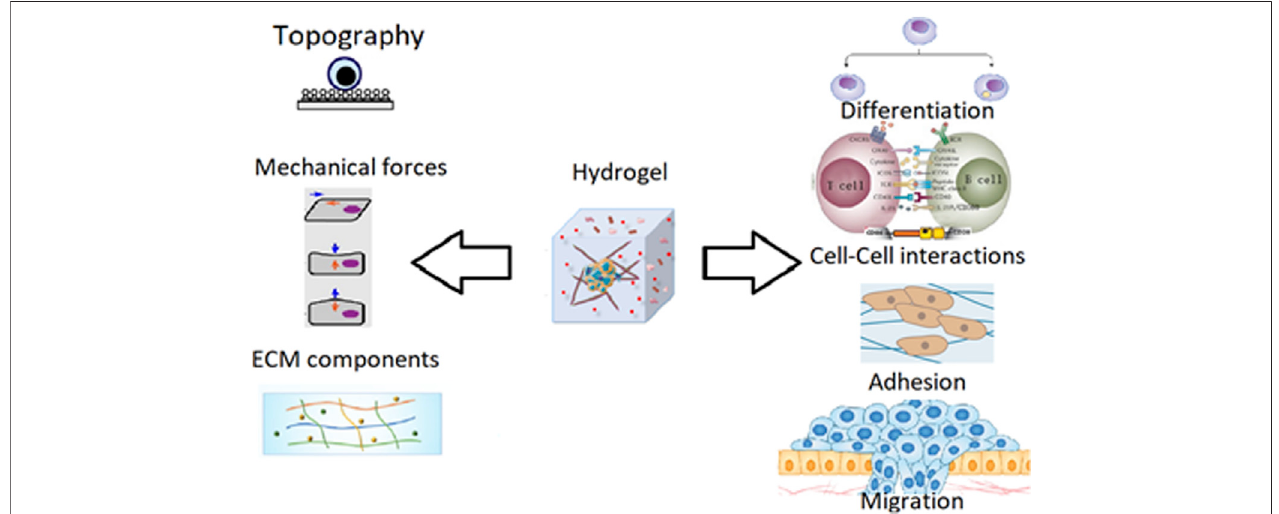
FIGURE 2 | Hydrogel properties and behavior (Liu et al.,